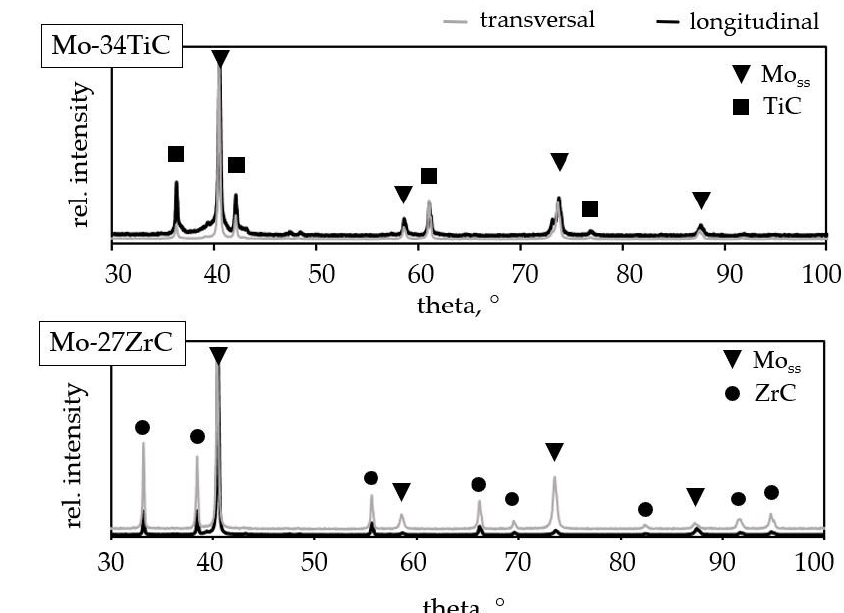
Figure 1. SEM ‐ BSE images of Mo ‐ 34TiC and Mo ‐ 27ZrC in longitudinal and transversal section, rep ‐ resenting eutectic colonies as well as dendritic regions. The Mo solid solution is the bright grey phase, whereas TiC and ZrC are depicted as the dark grey phases.